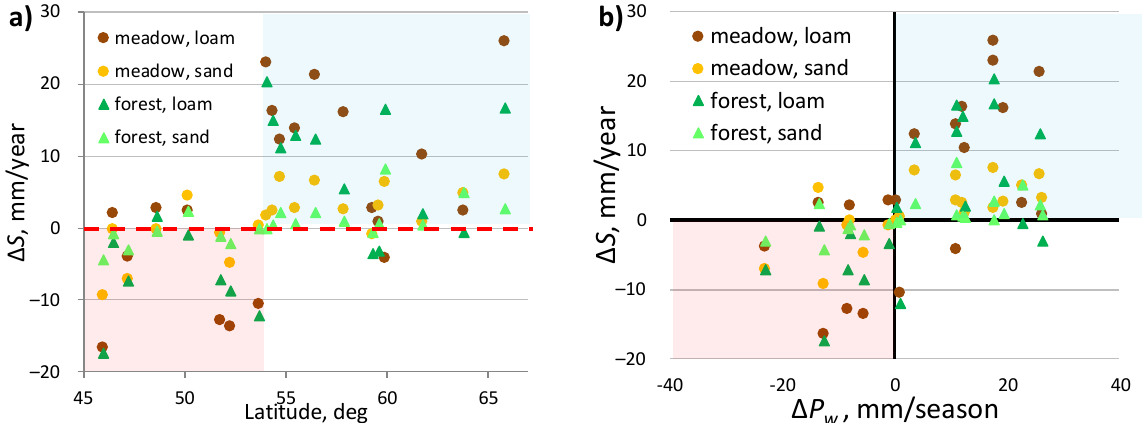
Figure 8. Latitudinal modern changes in mean annual surface runoff Δ S ( a ) and its dependence on changes in winter precipitation Δ P w ( b ).